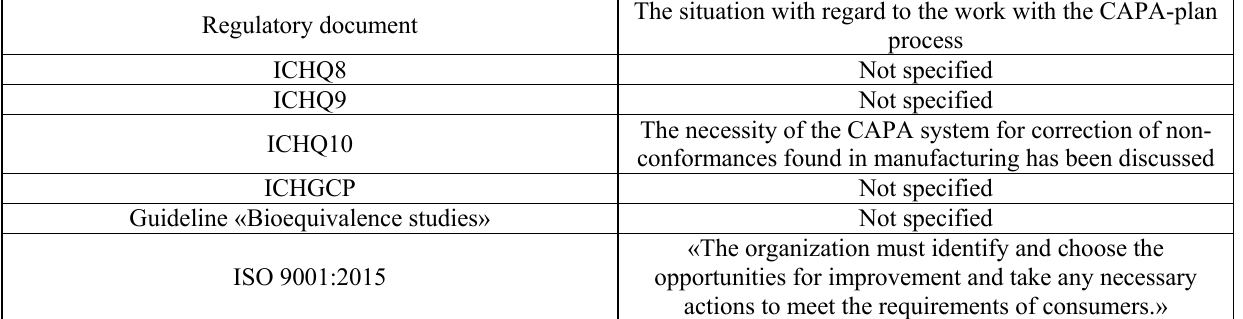
Regulation of the CAPA-planning method use for the correction and prevention of